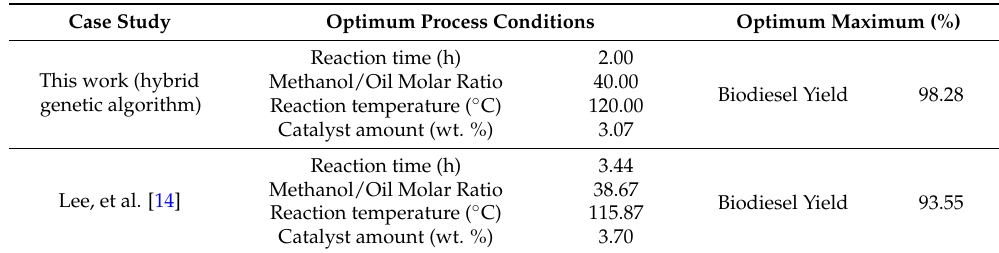
Table 8. Results for the case study on the biodiesel